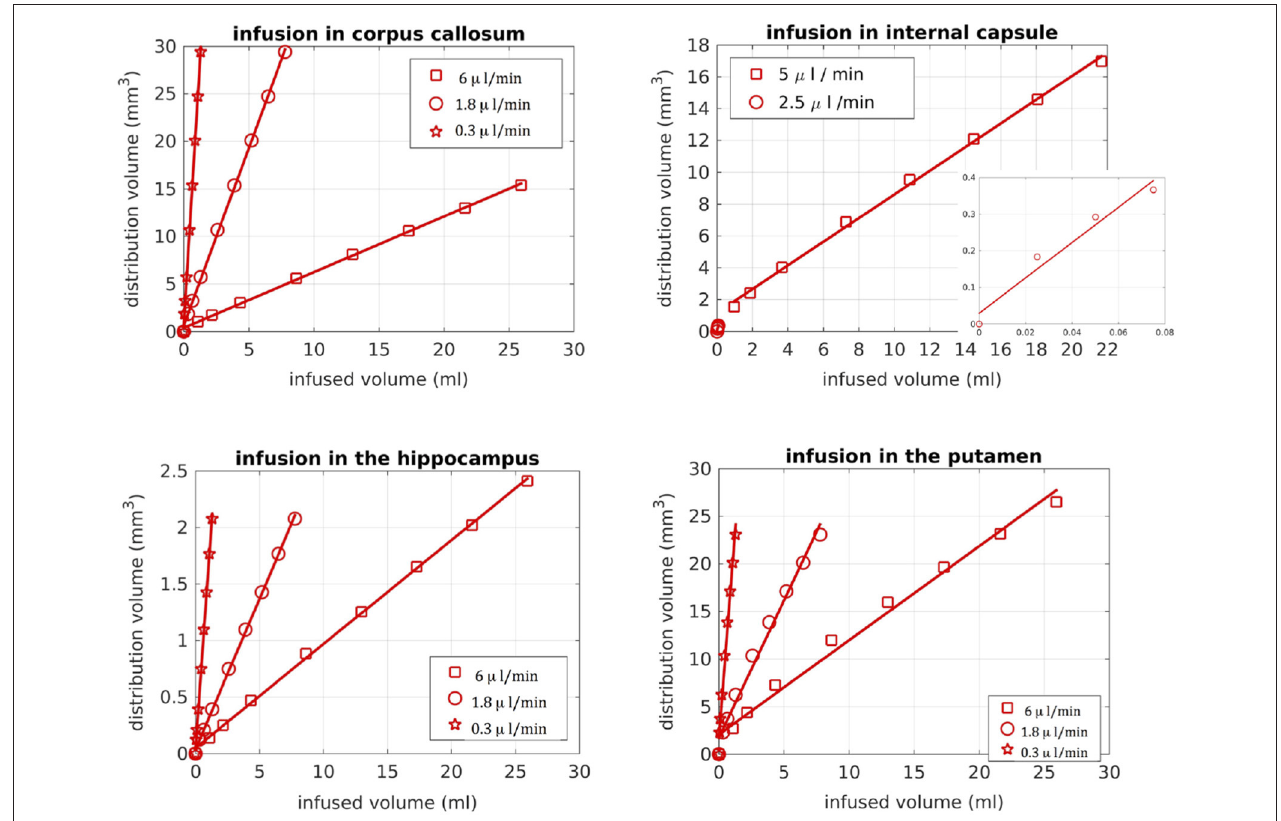
FIGURE 11 | Distribution volume vs. infused volume, for the R-model. The relationship is linear for all infusion